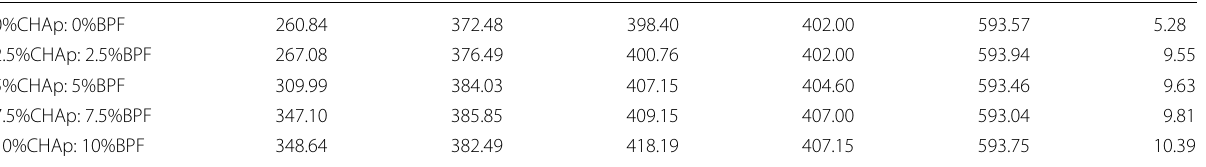
Table 5 Degradation temperatures of composites with CHAp and